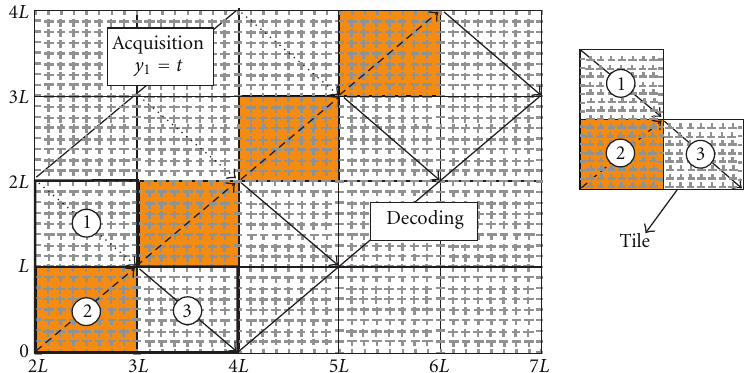
Figure 7: DFG for single-flow structures of (SFS, Π = 0, π =